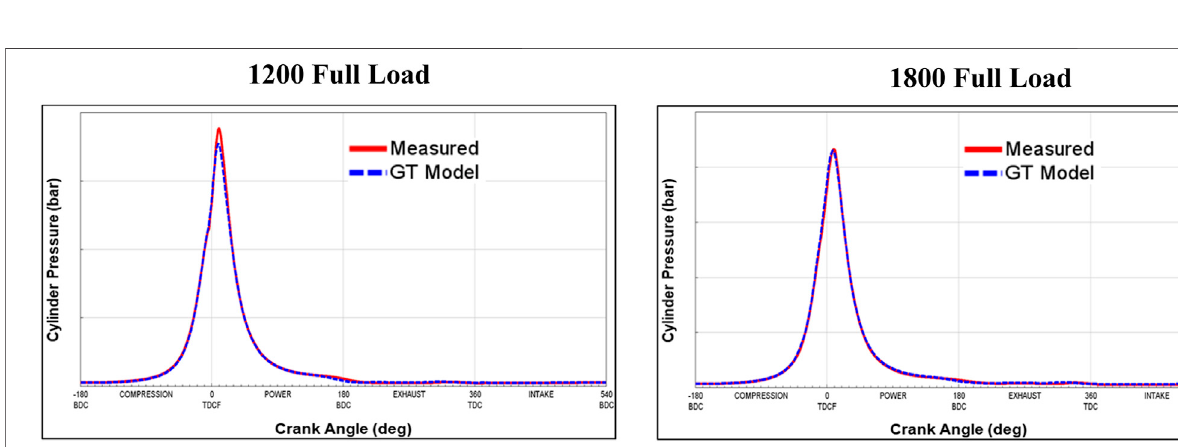
Frontiers in Mechanical Engineering |